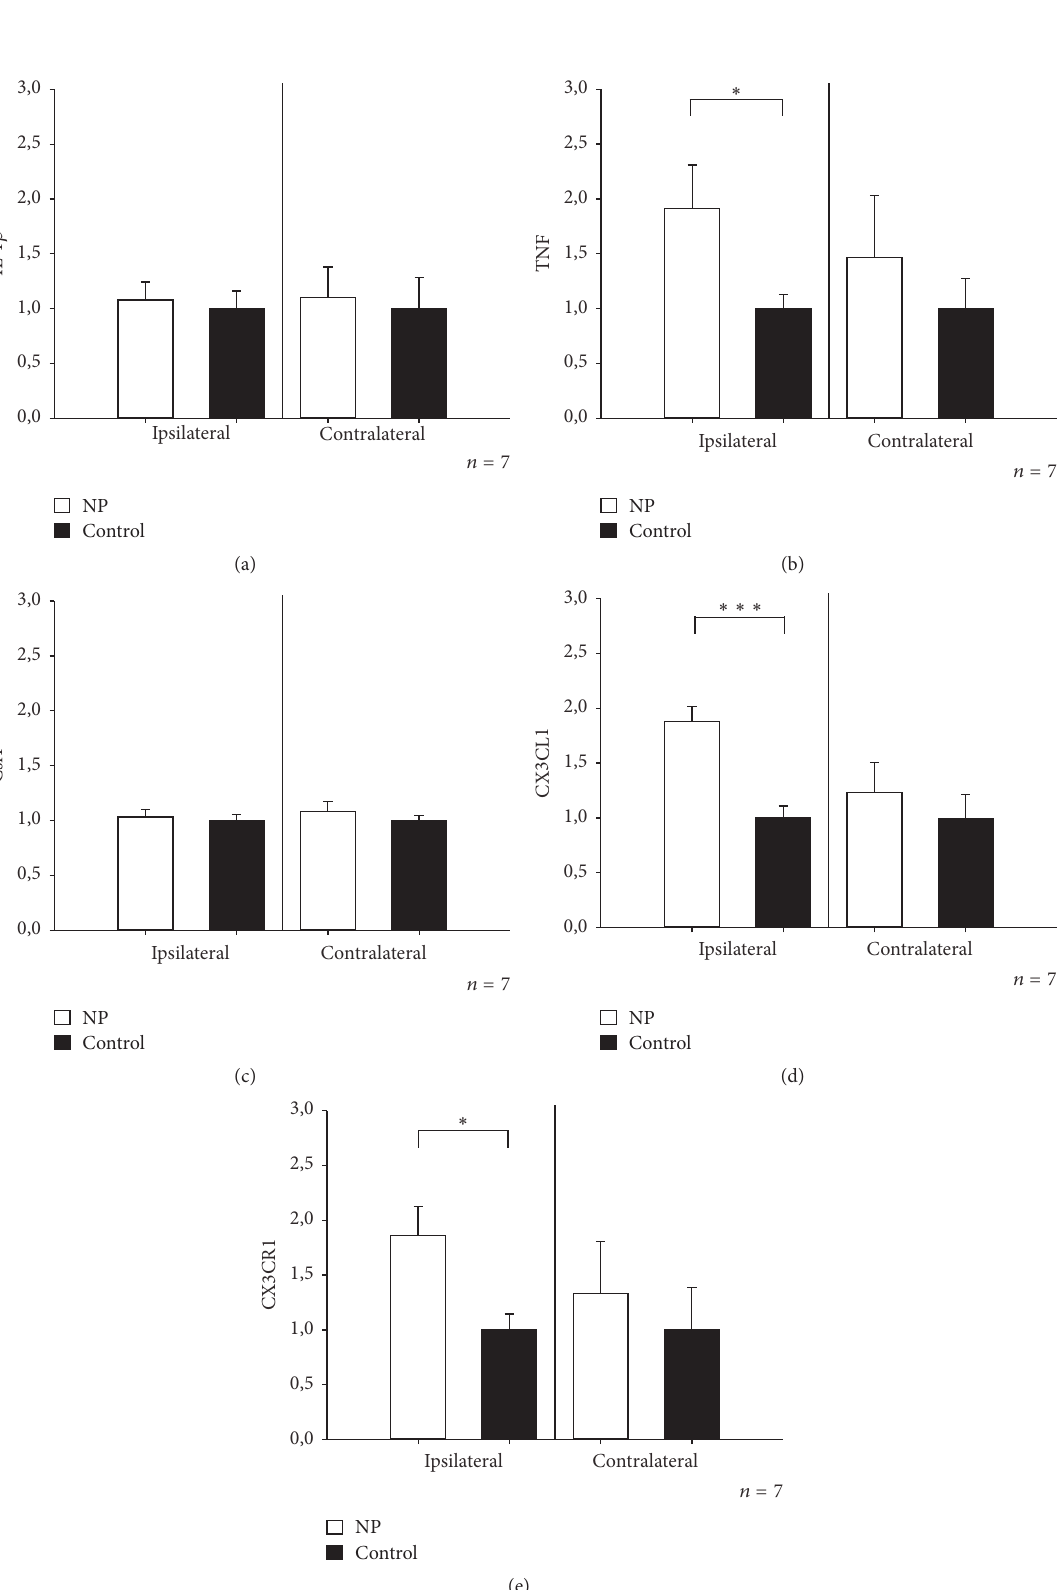
Figure 4: Fold expression of (a) IL-1 𝛽 , (b) TNF, (c) Csf1, (d) CX3CL1, and (e) CX3CR1 in the ipsi- and contralateral DRG after NP application onto the dorsal nerve roots. ∗ 𝑃 < 0.05 , ∗∗∗ 𝑃 < 0.001 , Student’s 𝑡